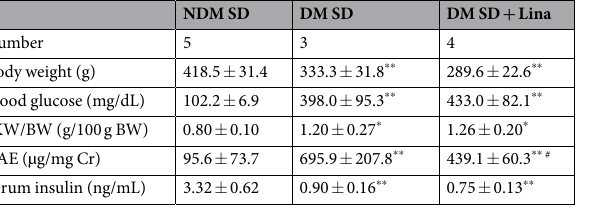
Table 1. General characteristics of experimental groups. NDM SD, nondiabetic model Sprague-Dawley; DM SD, diabetic model Sprague-Dawley; Lina, linagliptin; rKW/BW, right kidney weight/body weight; UAE, urinary albumin excretion. Data expressed as means ± SD. * P < 0.05, ** P < 0.01 vs. NDM SD, # P < 0.05 vs. DM